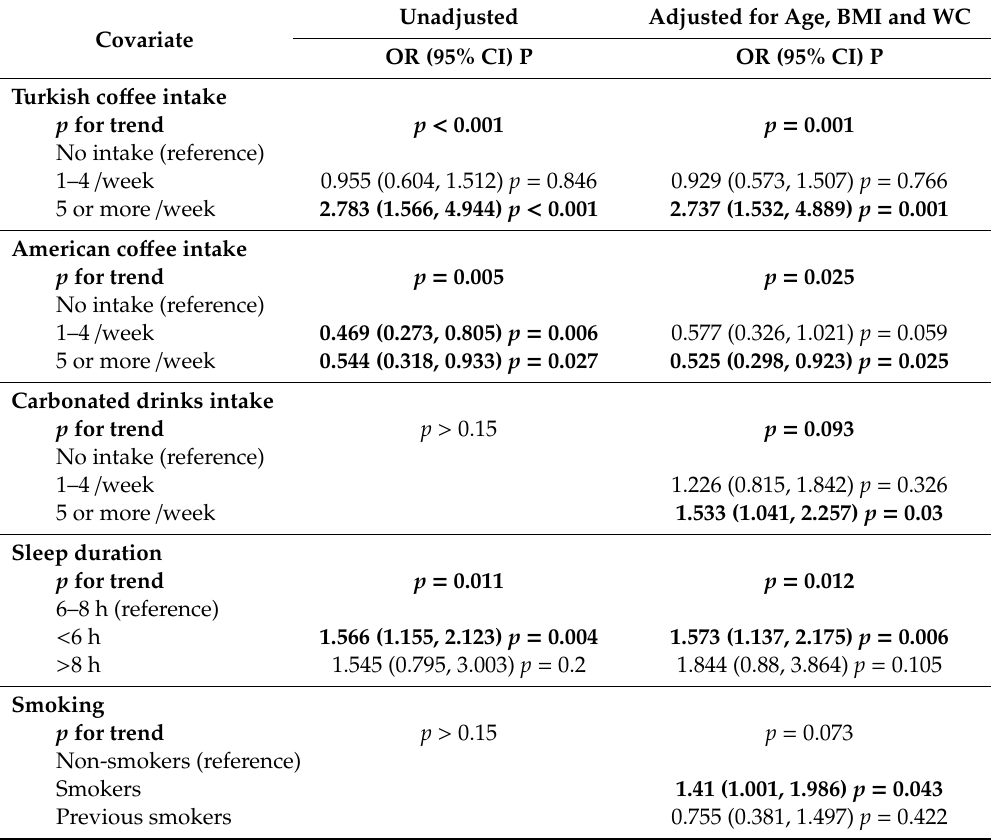
Table 3. Unadjusted and adjusted Odds Ratios (OR) with its 95% Confidence Interval (CI) for dietary and lifestyle predictors of dyslipidemia in